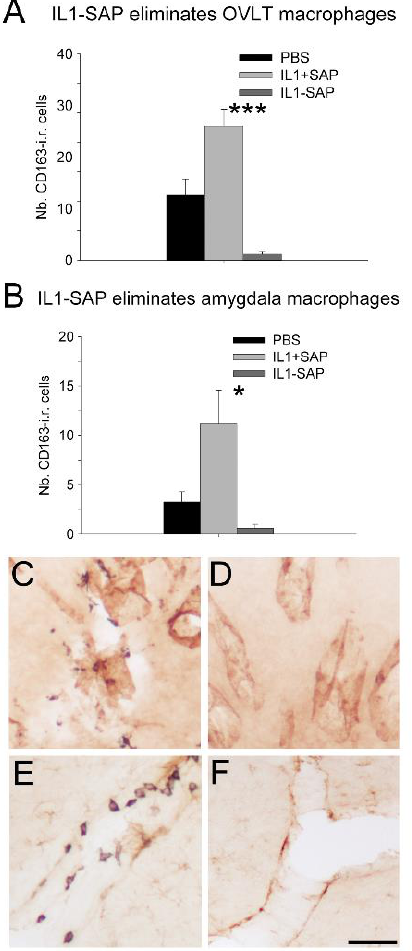
Figure 1. Effects of intracerebroventricular IL-1ß-saporin conjugate administration on brain perivascular cells in the organum vasculosum laminae terminalis (OVLT; A , C , D ) and amygdala ( B , E , F ). In these structures, the IL-1ß-saporin conjugate reduced the number of CD163 immunoreactive (CD163 i.r.) cells ( A – F ) without affecting labelling for the endothelial cell marker von Willebrand factor ( C , D ) and the astrocyte marker glial fibrillary acidic protein ( E , F ). Brown labeling indicates von Willebrand factor ( C , D ) and glial fibrillary acidic protein ( E , F ) and black staining CD163. * p < 0.05; *** p < 0.001. IL1-SAP compared to IL1 + SAP group. IL1: interleukin-1ß; IL1-SAP: interleukin-1ß conjugated to saporin; IL1 + SAP: interleukin-1ß not conjugated to saporin; PBS: phosphate-buffered saline; SAP: saporin. Group sizes: n = 5–9. Scale bar represents 100 µ